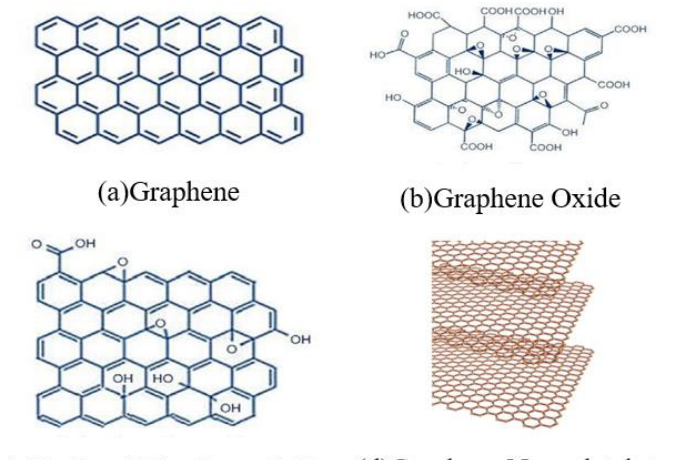
Figure 1. Four types of graphene fillers for GRCCMs. ( a ) Graphene, ( b ) Graphene Oxide, ( c ) Re- duced Graphene Oxide. Reprinted with permission from Ref. [38]. Copyright 2021 Elsevier. ( d ) Graphene Nanoplatelets. Reprinted with permission from Ref. [39]. Copyright 2021 Elsevier.